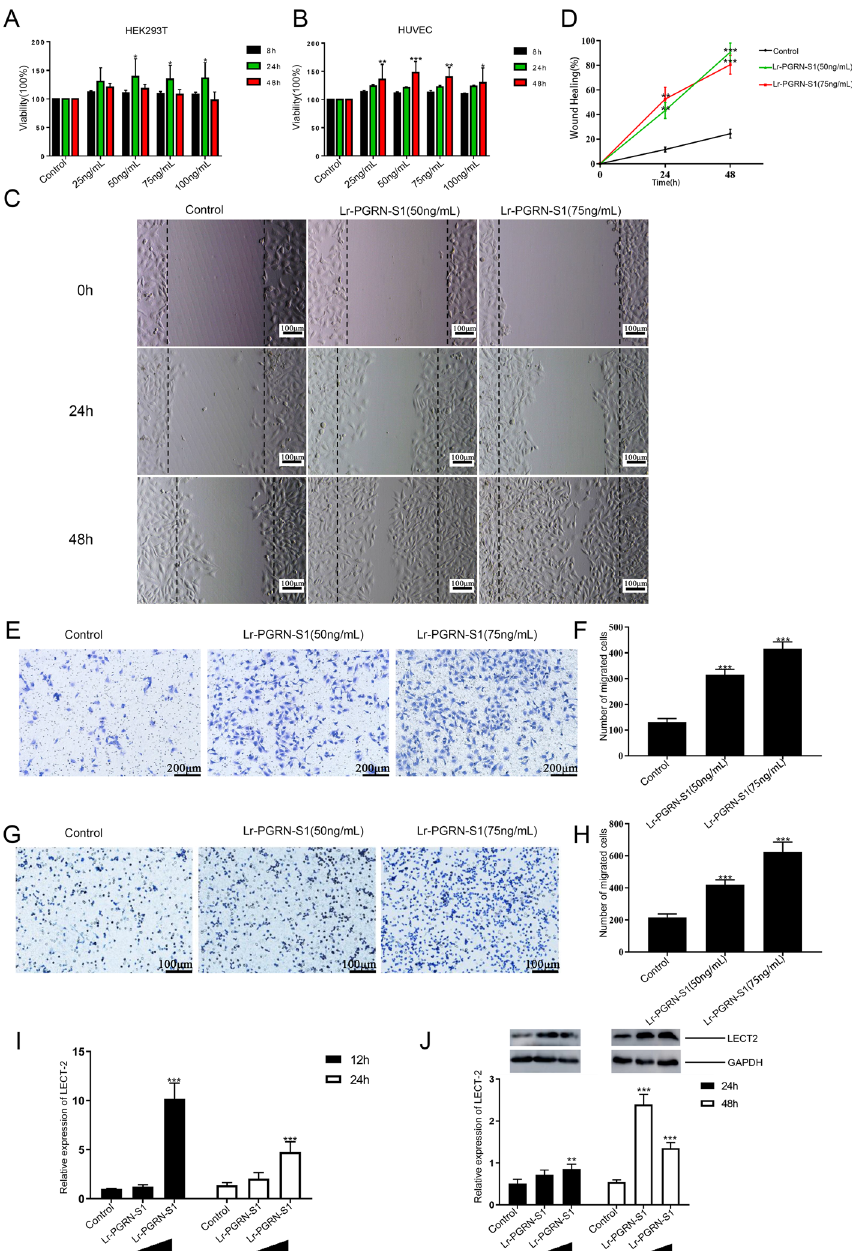
Fig. 4 Lr-PGRN-S1 promotes cell proliferation and migration. A , B rL-PGRN-S1 promoted HEK293T cell and HUVEC proliferation. HEK293T cells and HUVECs were treated with rLr-PGRN-S1 of different concentrations. The viability of the cells was detected using the CCK-8 assay. C Wounds were produced by scratching the bottom of the cell culture plate using a pipette tip. Cells were incubated with IPC for up to 48 h. To observe the wound healing effect, the area around the wounds was assessed at indicated time points. PBS was used as control. D Line chart showing the statistics of the results in C. E Transwell assay showing promotion of migration in rL-PGRN-S1-treated HUVECs; F graph of rL-PGRN-S1 promotion of HUVEC migration. G Transwell assay showing promotion of migration in rL-PGRN-S1-treated lamprey supraneural body. H Statistical graph of rL-PGRN-S1. I Effect of rL-PGRN-S1 on expression of chemokine LECT2 as determined by qRT-PCR. J Effect of rL-PGRN-S1 on expression of chemokine LECT2 as determined by western blot. The lower histogram shows the statistics of western blot. The probability of statistical differences between experimental groups was determined by Student’s t -test. All data presented as mean SD based on three independent samples with ± three replicates per sample. * P < 0.05, ** P < 0.001, *** P <